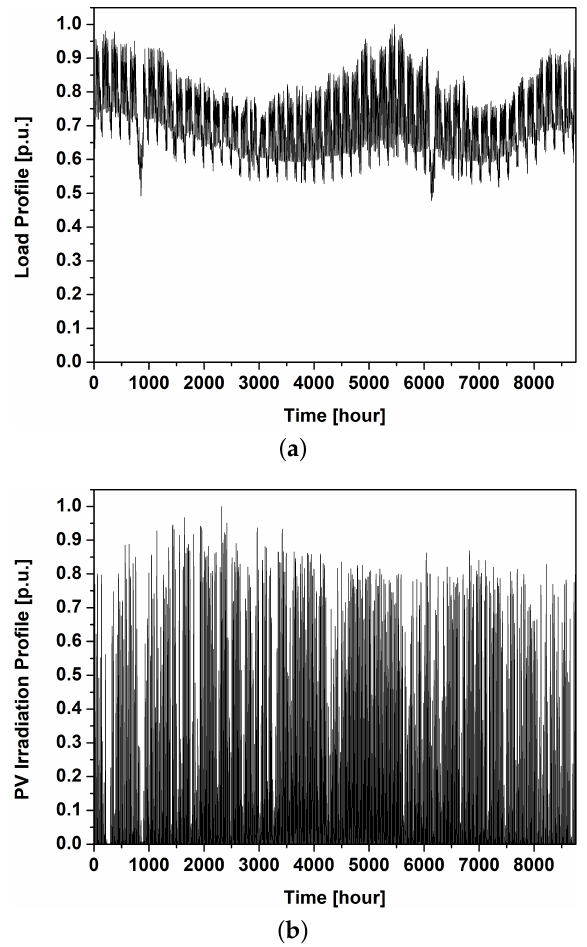
Figure 2. South Korea’s One-Year PV Output and Power Usage Pattern of Load. ( a ) Power Usage Pattern of Load [34]. ( b ) PV Output Pattern